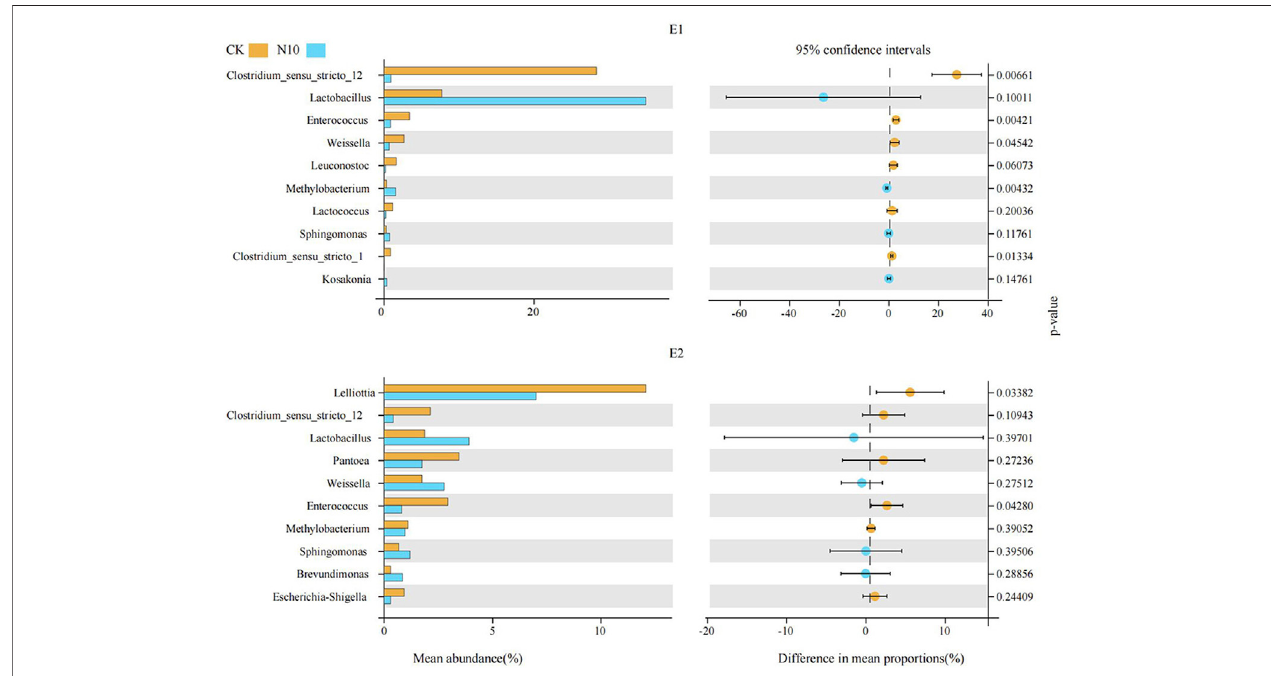
FIGURE 4 | Difference in the bacterial community between the control and 10% N. cadamba leaf meal treatment based on Welch ’ s test (E1 and E2, experiments 1 and 2; CK, control; N10, mixed with 10% N. cadamba leaf meal).